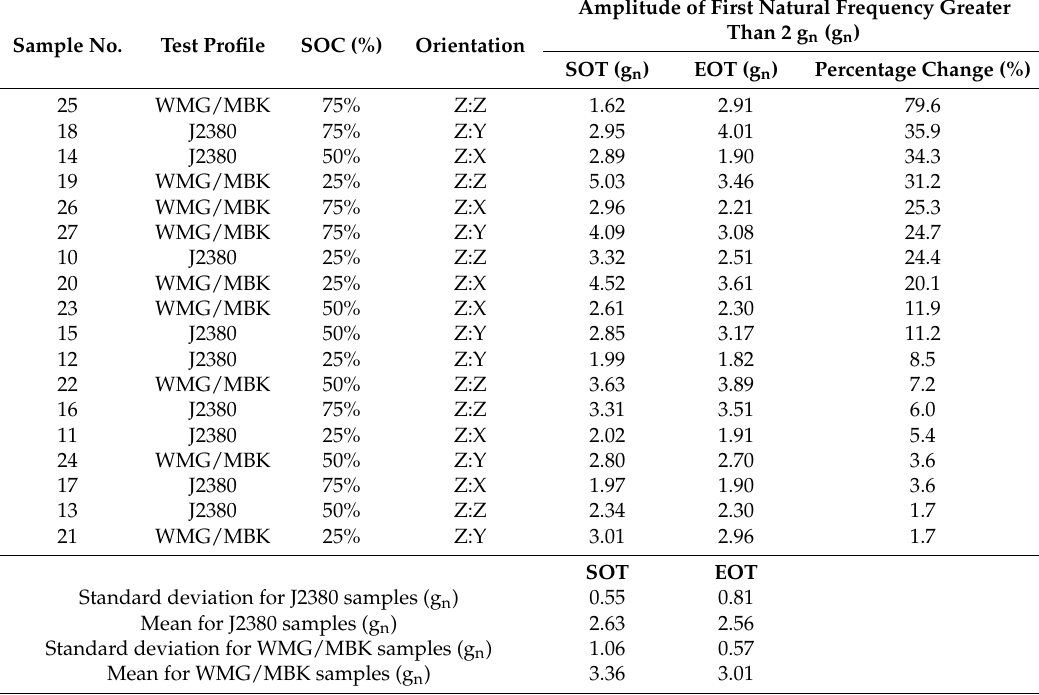
Table 6. Summary of change in amplitude of observed first cell resonance for all test samples.